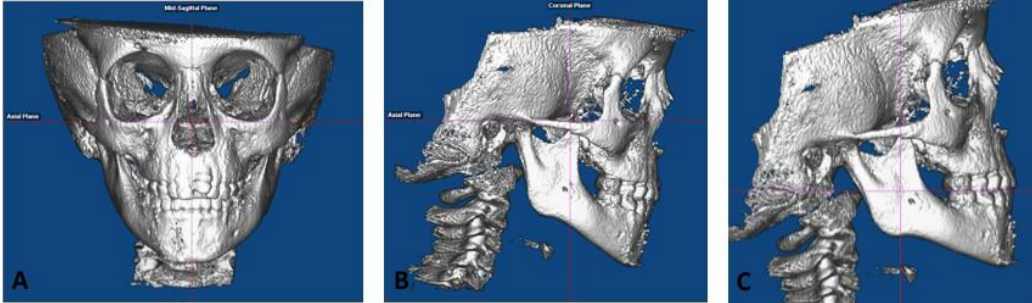
Figure 1. CBCT Orientation ( A ) Roll and Yaw, ( B ) Pitch (non-tooth-bearing, skeletal measurements), and ( C ) Pitch (tooth- bearing, dentoalveolar measurements).